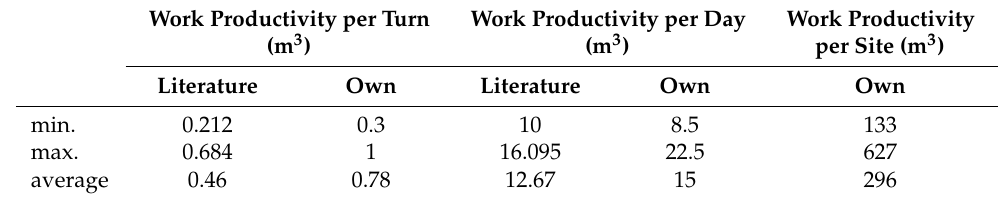
Table 4. The work productivity of horse logging.